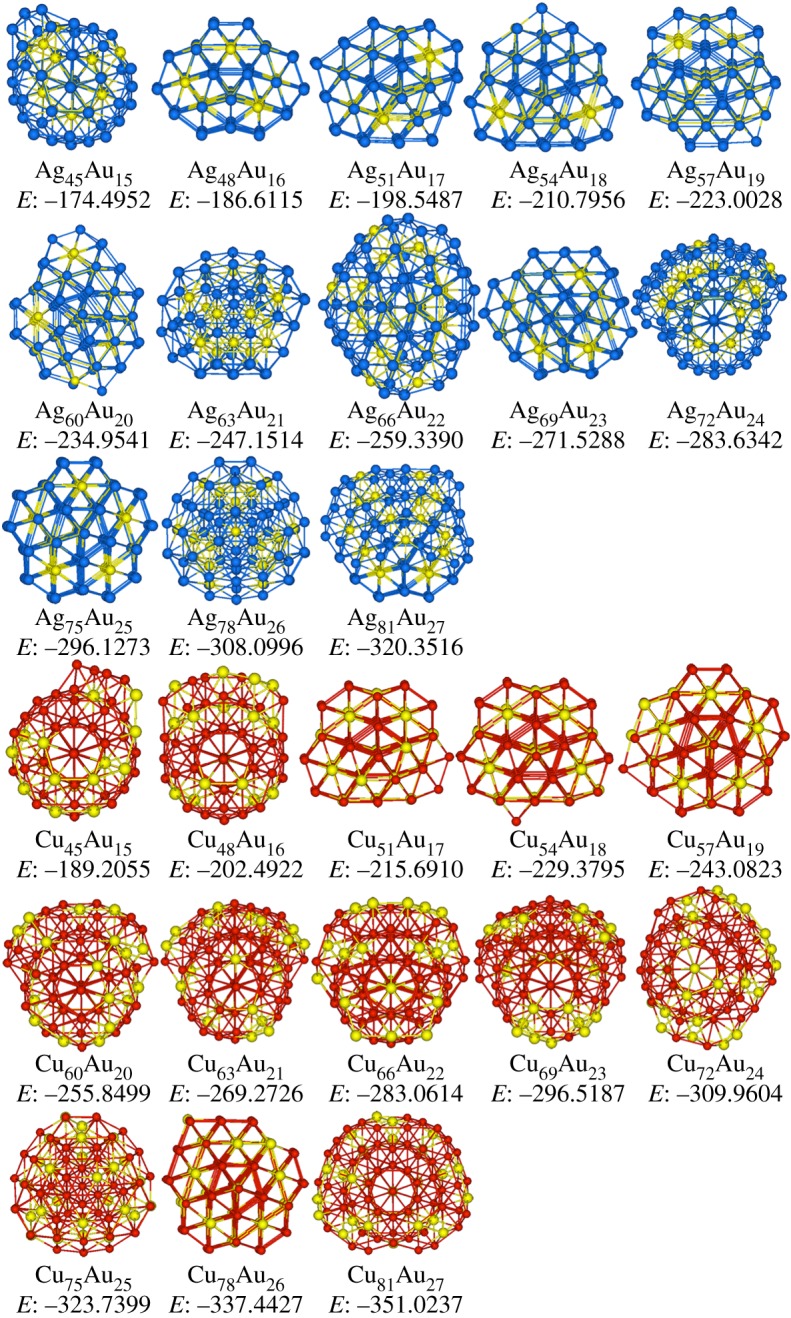
Stable structures of Ag3nAun and Cu3nAun (n = 15–27) clusters, and Cu, Ag and Au atoms are represented by red, blue and yellow spheres, respectively, and the potential energies E (eV) are also added.